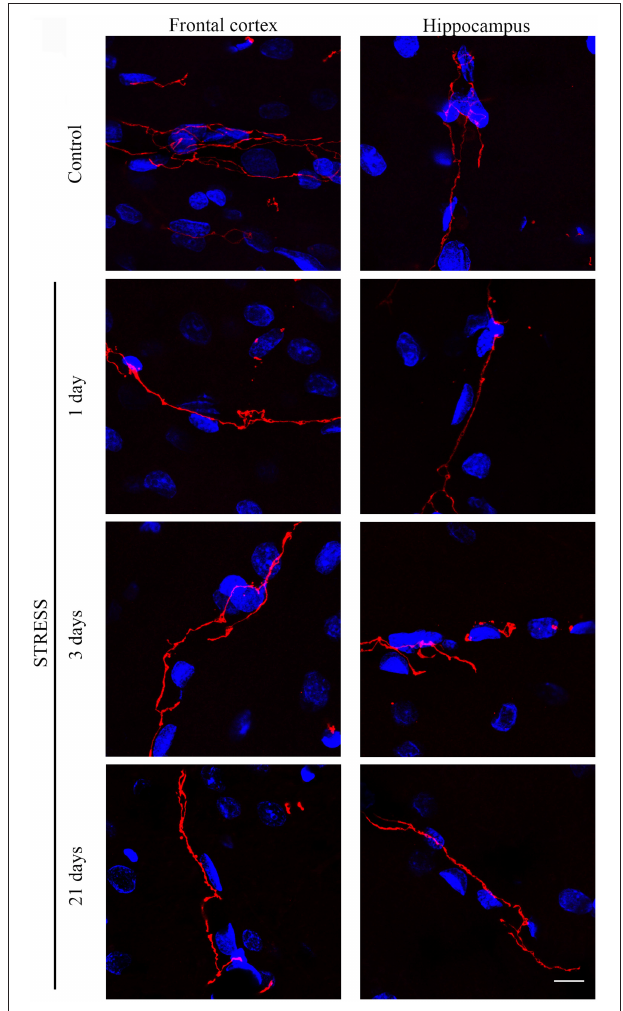
FIGURE 2 | Expression of claudin-5 in rat frontal cortex and hippocampus of control and stressed rats. Sagittal brain sections of control and stressed rats were immunostained for tight junction protein claudin-5 of brain capillaries. Red color: immunostaining for claudin-5. Blue color: cell nuclei stained with Hoechst dye 33342. Scale bar: 15 µ